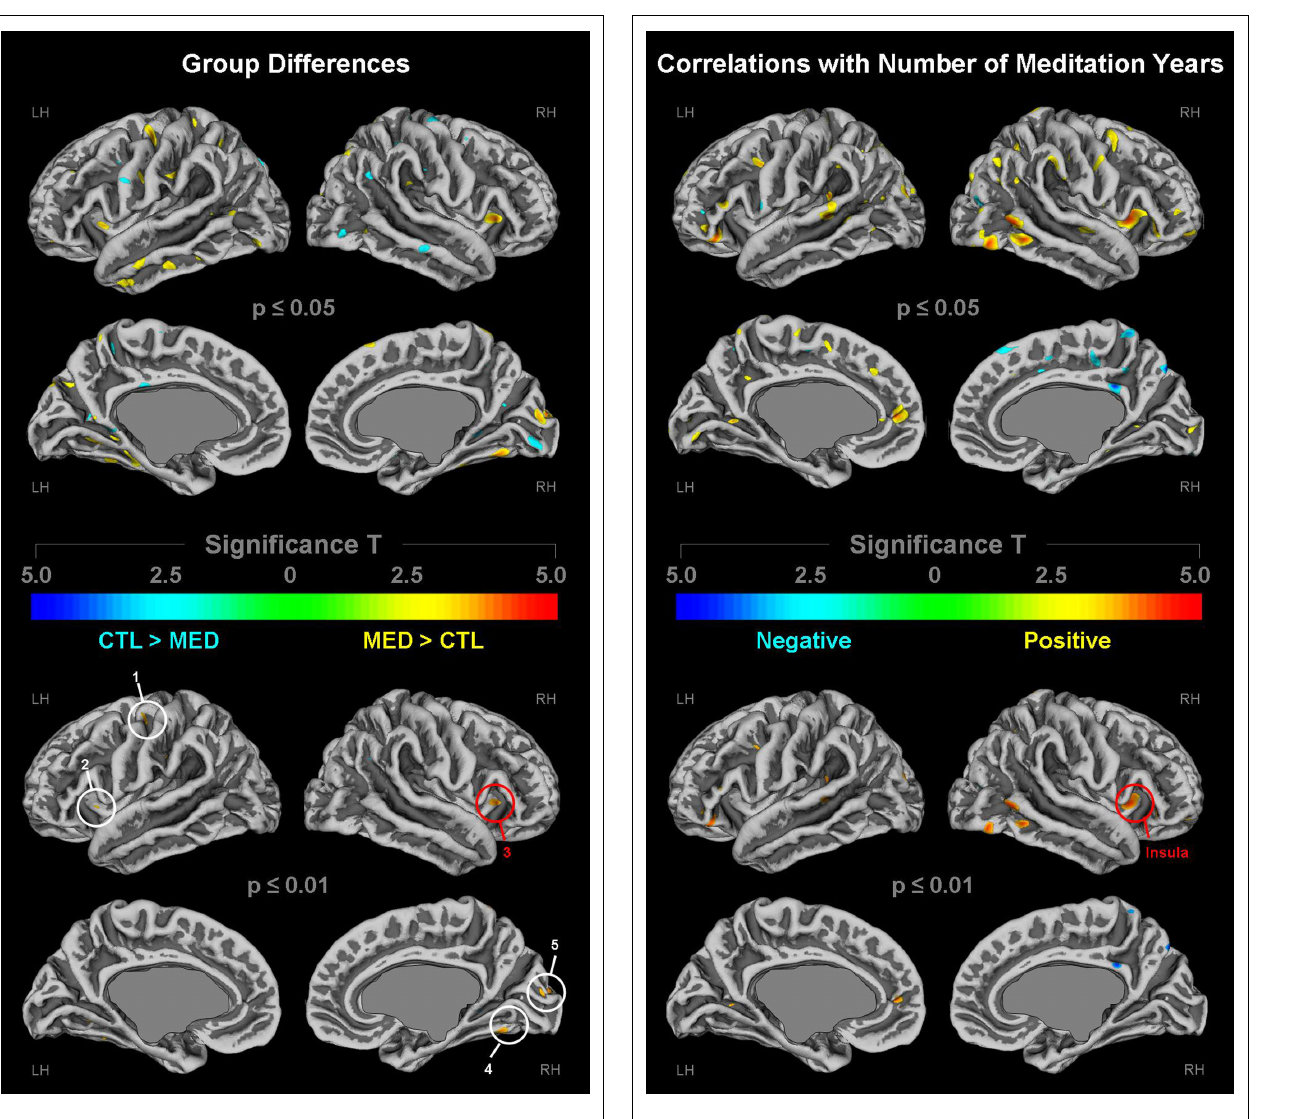
FIGURE 3 | Links between cortical gyrification and number of meditation years. Shown are correlations at p ≤ 0.05 (upper panel) and p ≤ 0.01 (lower panel), uncorrected for multiple comparisons.The color bar encodes significance ( T ). Areas with positive correlations (i.e., more meditation years link with more gyrification) are depicted in yellow/orange; negative correlations (i.e., more meditation years link with less gyrification) are depicted in cyan. Callosal, subcallosal, and midbrain regions have been excluded on the medial surface maps.The red circle indicates the global maximum. LH, left hemisphere; RH, right